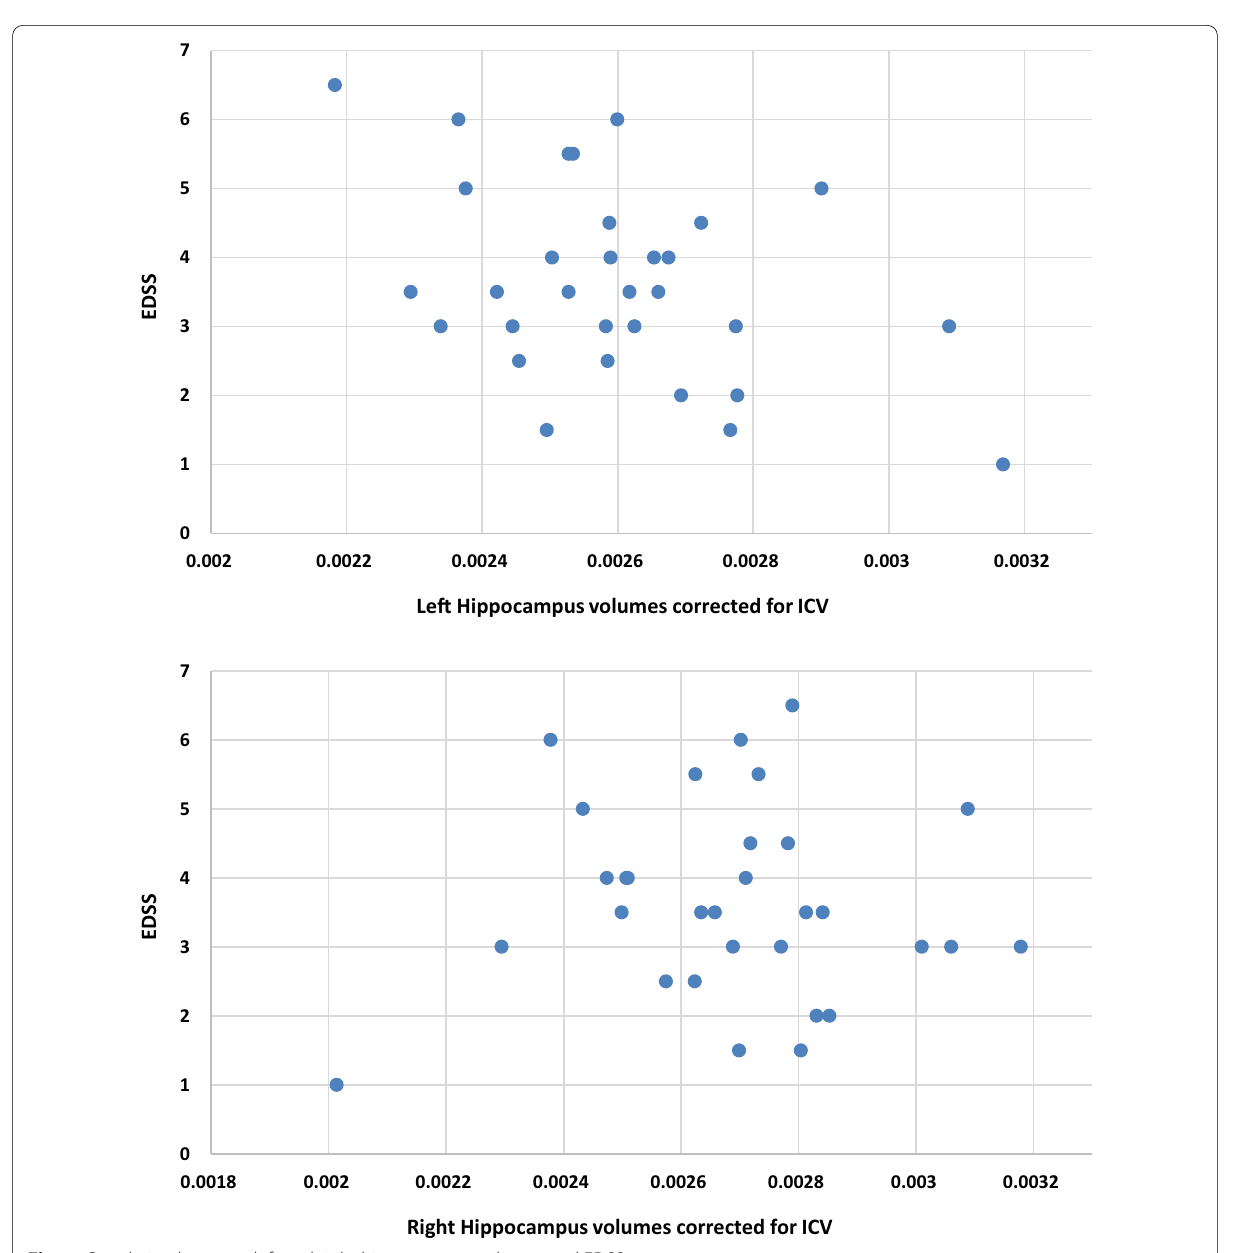
Fig. 4 Correlation between left and right hippocampus volumes and EDSS